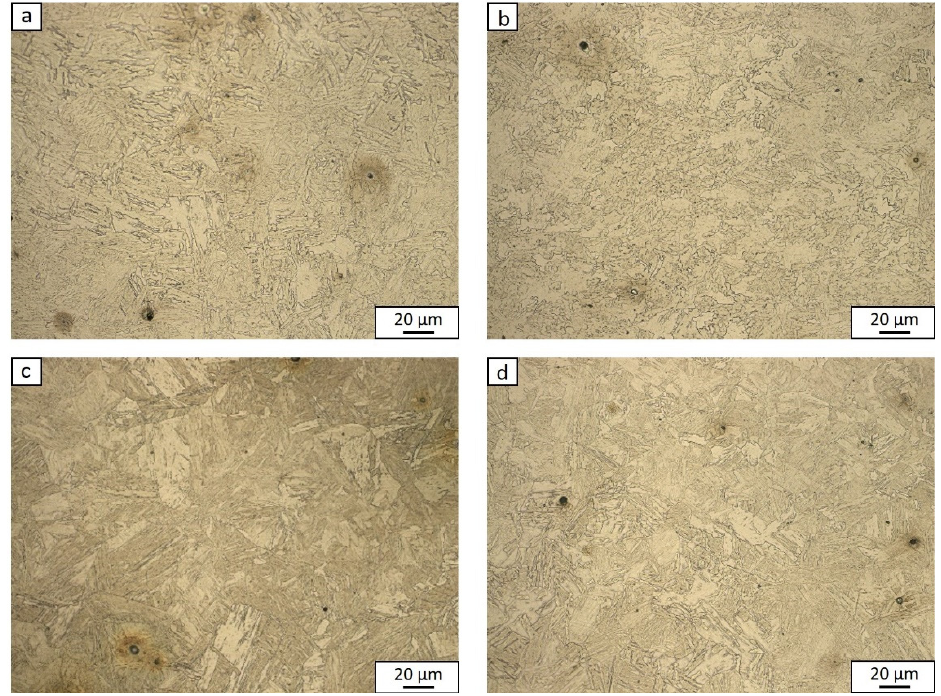
Figure 6. Martensitic structure with a small part of retained austenite of steel hardened in water after deformation: 0.2 ( a , c ) and 0.69 ( b , d ); plastic deformation temperature: 900 °C ( a , b ); 1100 °C ( c , d ).